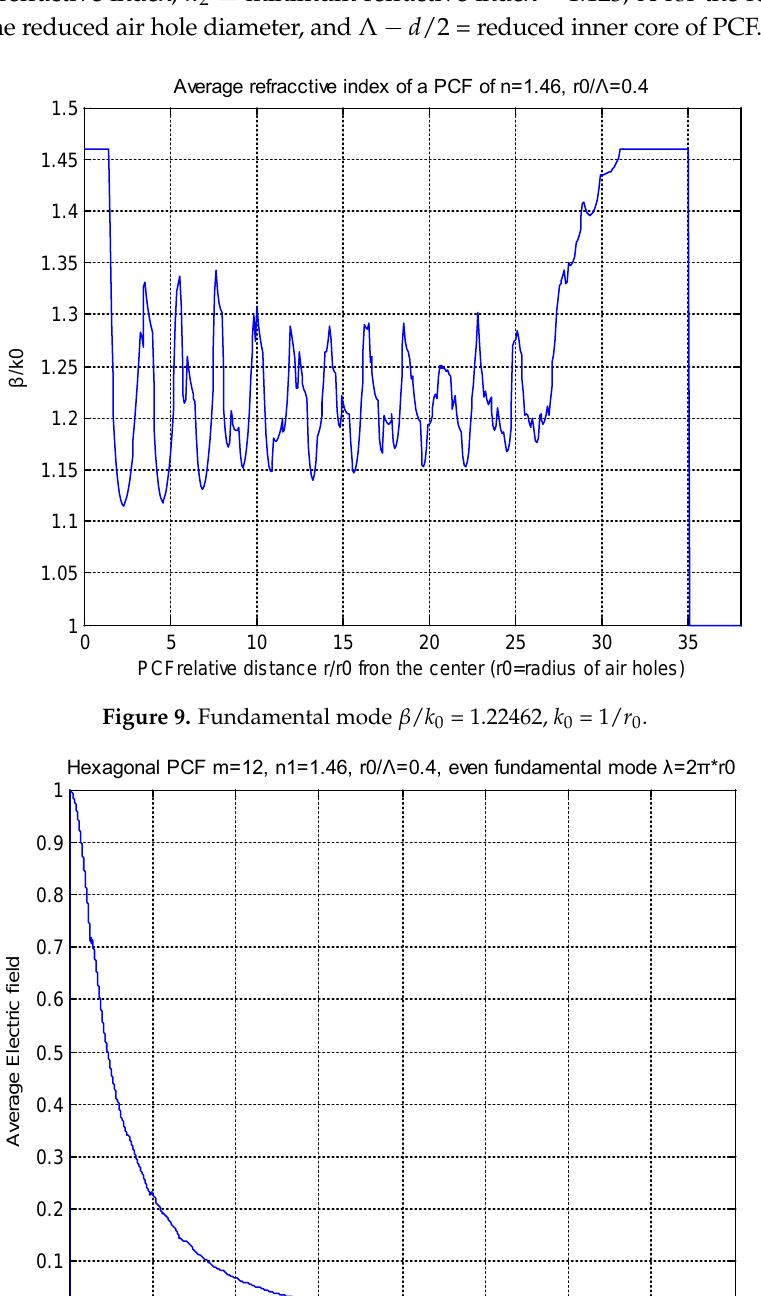
Figure 11. β /V diagram of the even fundamental for a PCF.